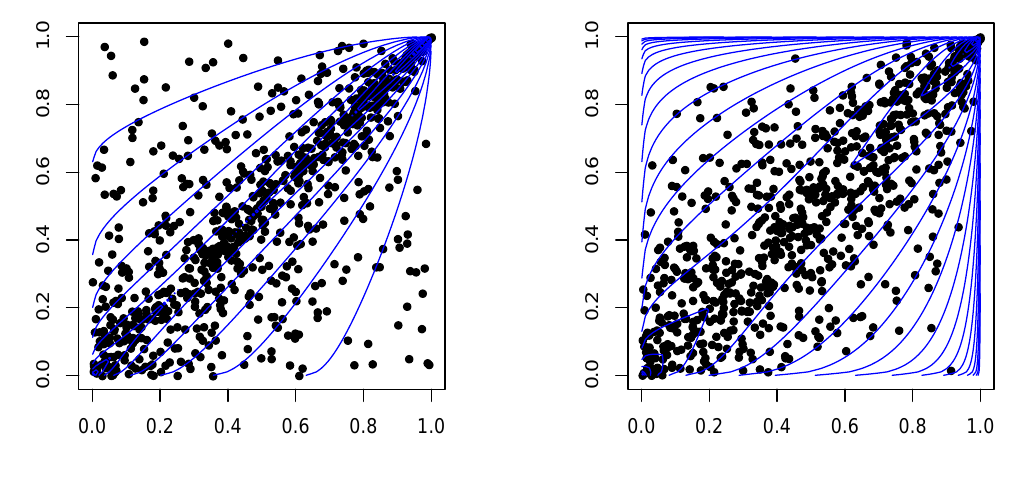
Figure 4: Scatterplots with 800 samples of the survival copulas of the MSMVE distributions generated by Example 2 and Exam- ple 3. The corresponding Pickands dependence functions are depicted in Figure 2 and the same parameters are